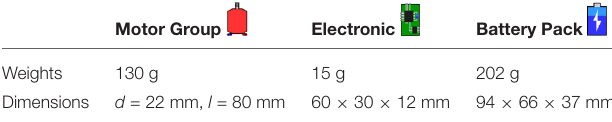
TABLE 2 | Technical specifications of the three mechanical subsystems. TABLE 3 | Data of shoulder torque, components to wear, cable length, and total volume criteria for each hybrid configuration and benchmark.